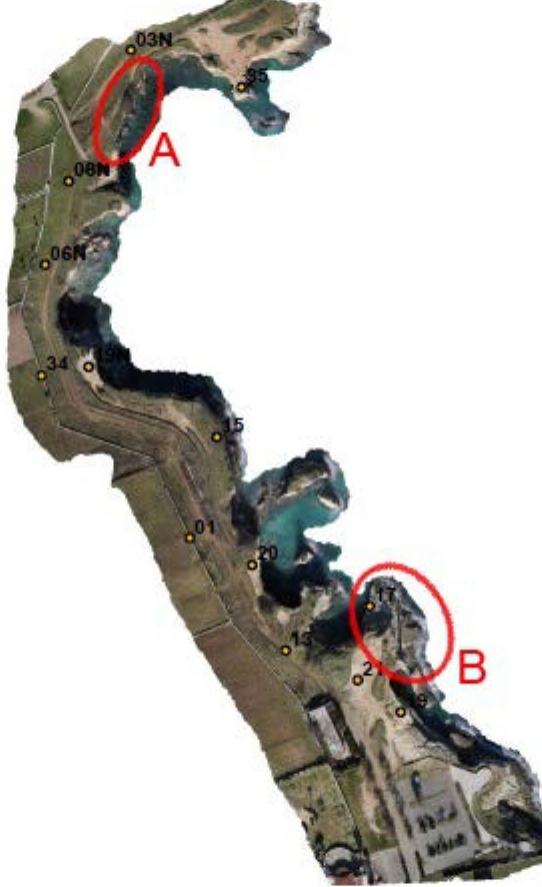
Figure 3: The location of Ground Control Point (GCP)